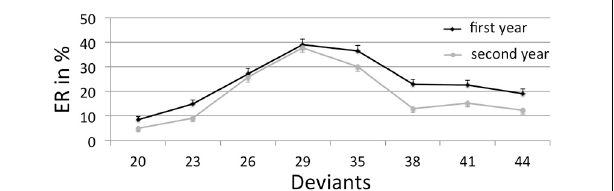
FIGURE 1 | Mean error rates (ER) and standard errors in % in the non-symbolic numerical comparison task, separately for the different measurement points (first year, second year) as a function of the different deviants (reference numerosity =